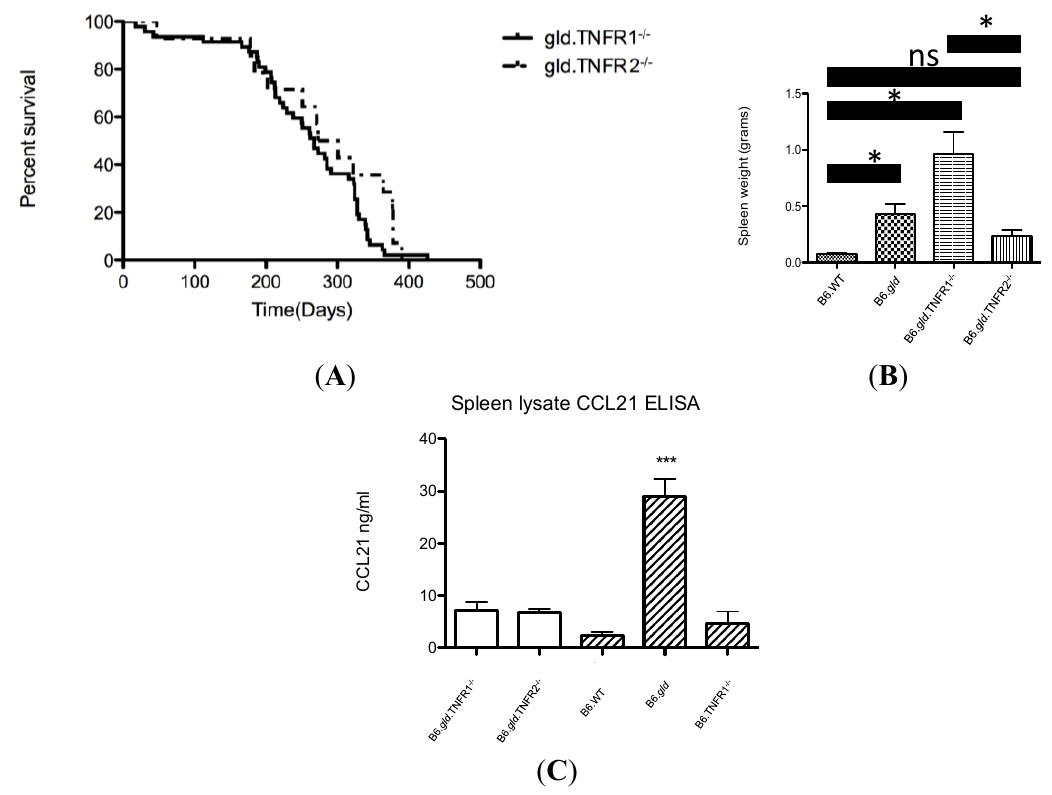
Figure 1. Comparative analysis of B6. gld .TNFR1 −/− and B6. gld .TNFR2 −/− mice with